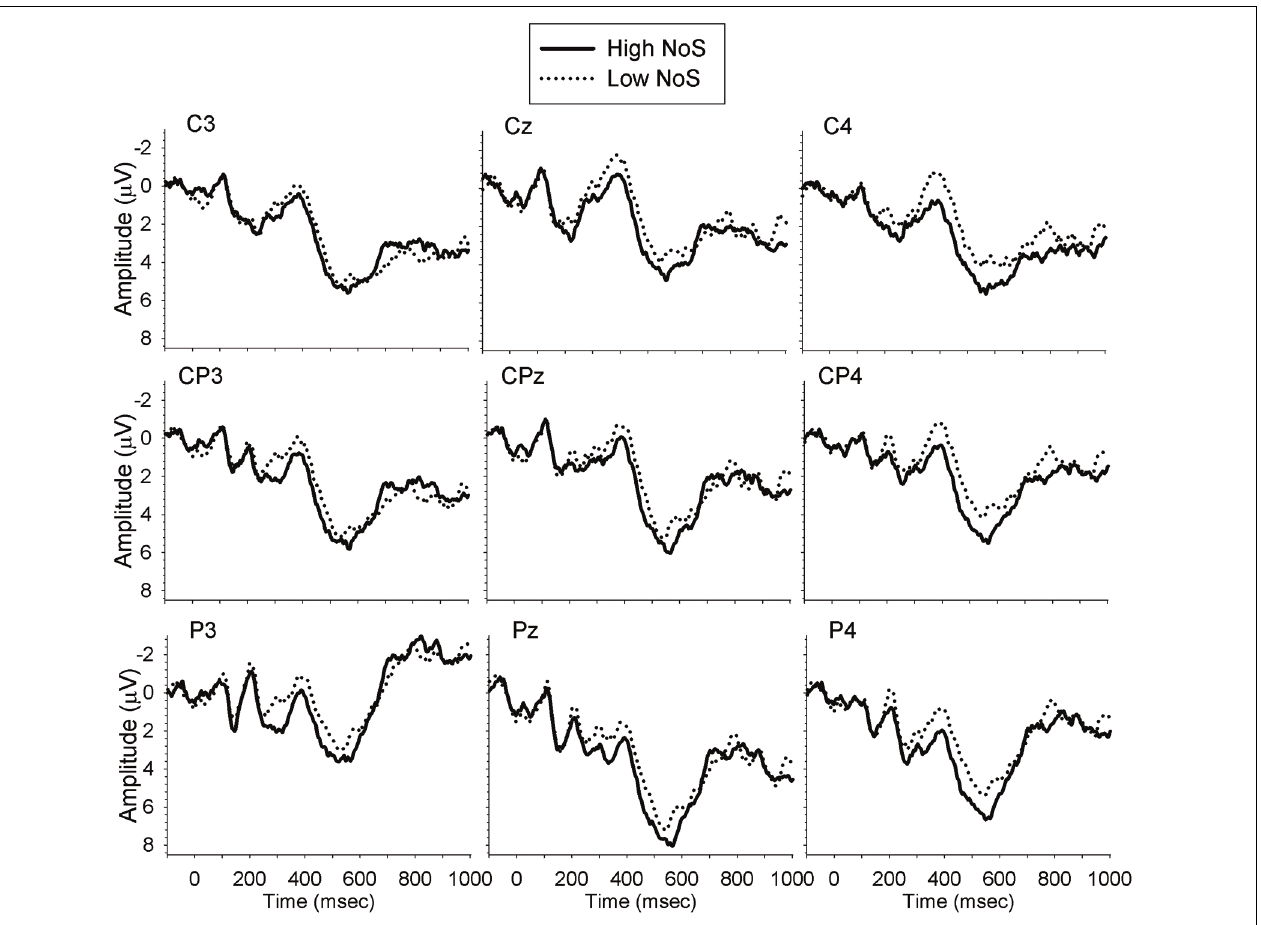
FIGURE 1 | Waveforms elicited by monolinguals performing the task in English